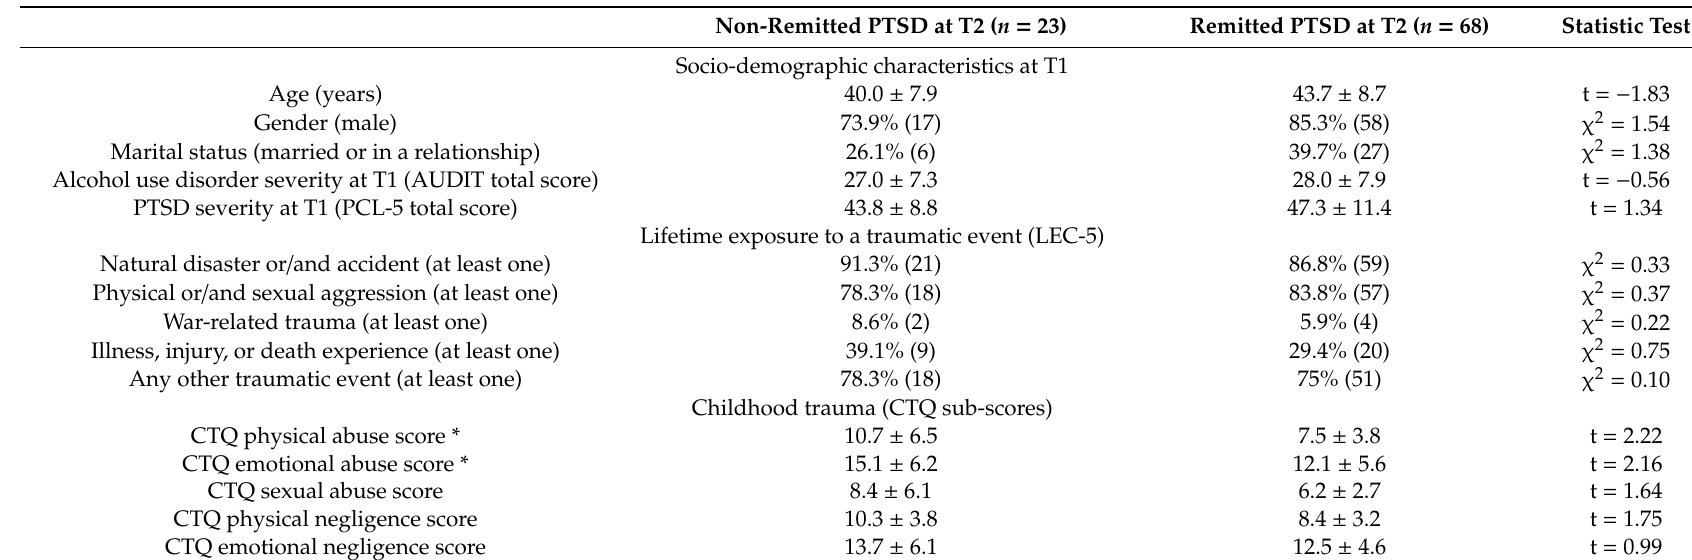
Table 2. Baseline characteristics at T1 associated with PTSD remission at T2 in univariate analyses ( n =